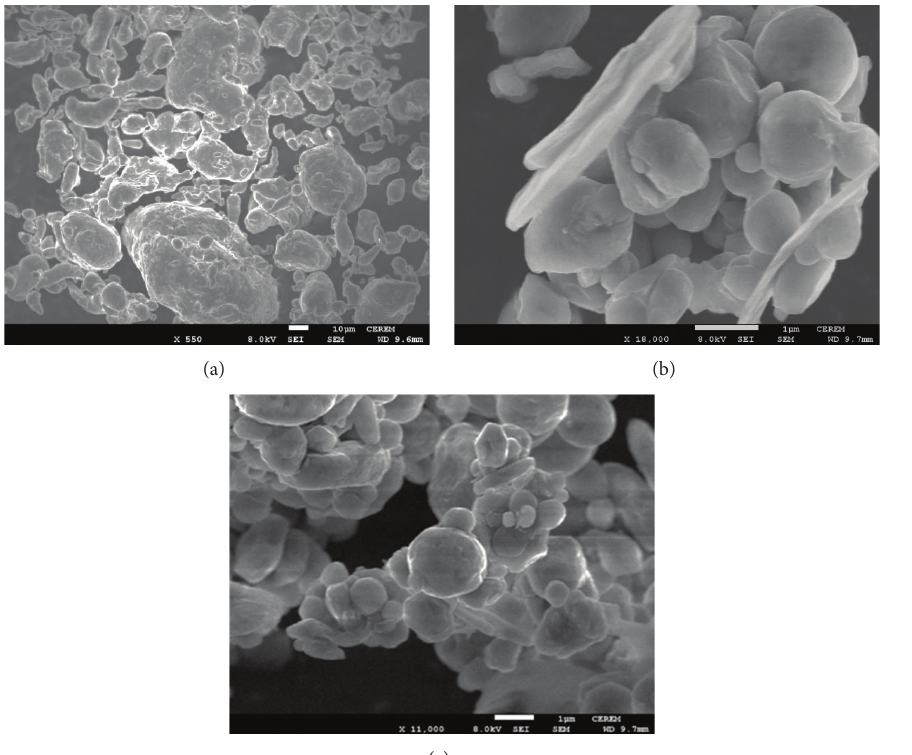
Figure 1: FESEM secondary electron images of as-received Al powder in (a) and Al powder that was produced by cryomilling for 7 hours in (b) and (c). Note the difference in